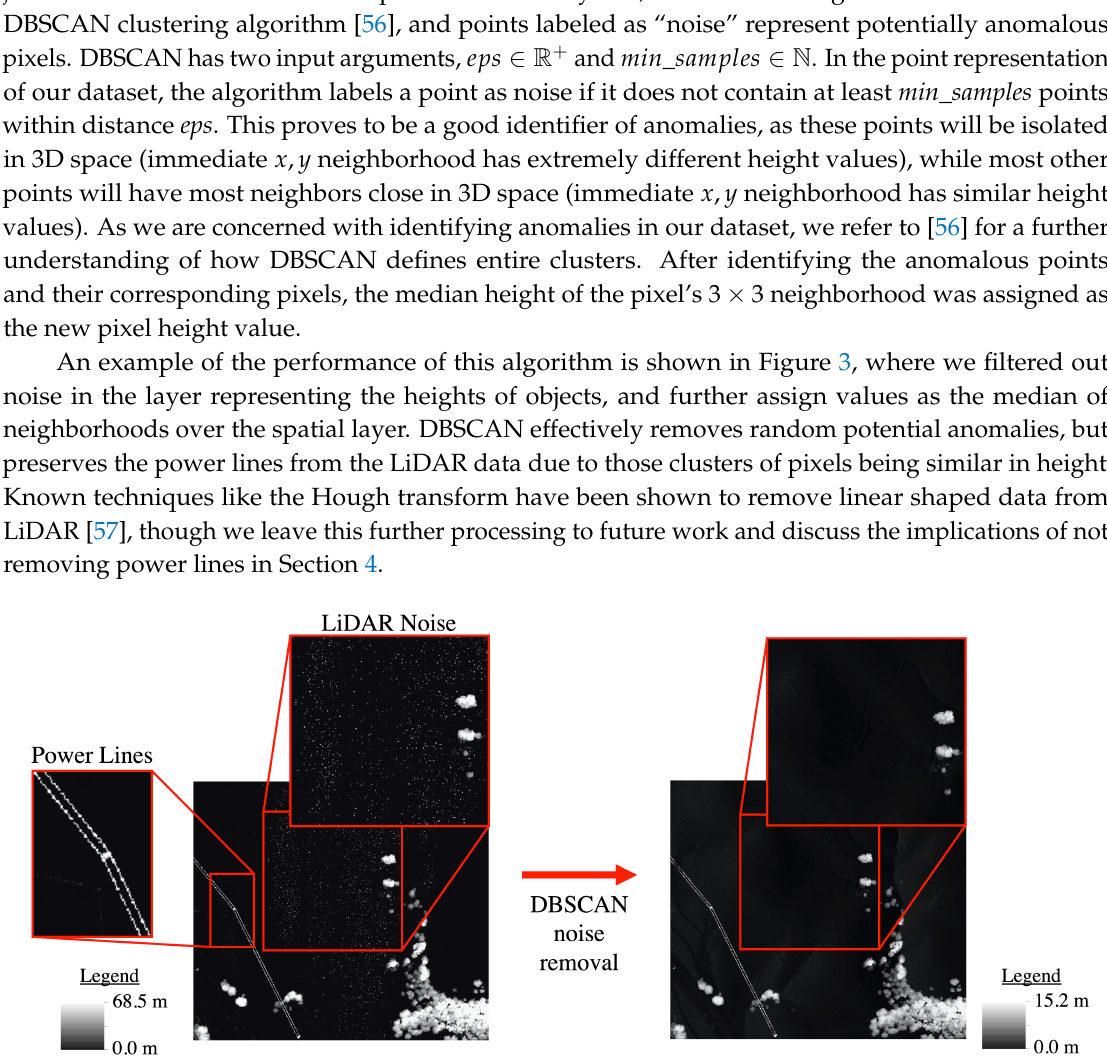
Figure 3. We analyze the raw normalized-digital surface model (DSM) (nDSM) of an area on the left with power lines and sensor noise. The nDSM on the right is the result after the DBSCAN algorithm removes the sensor noise, however does not remove power lines which we validated